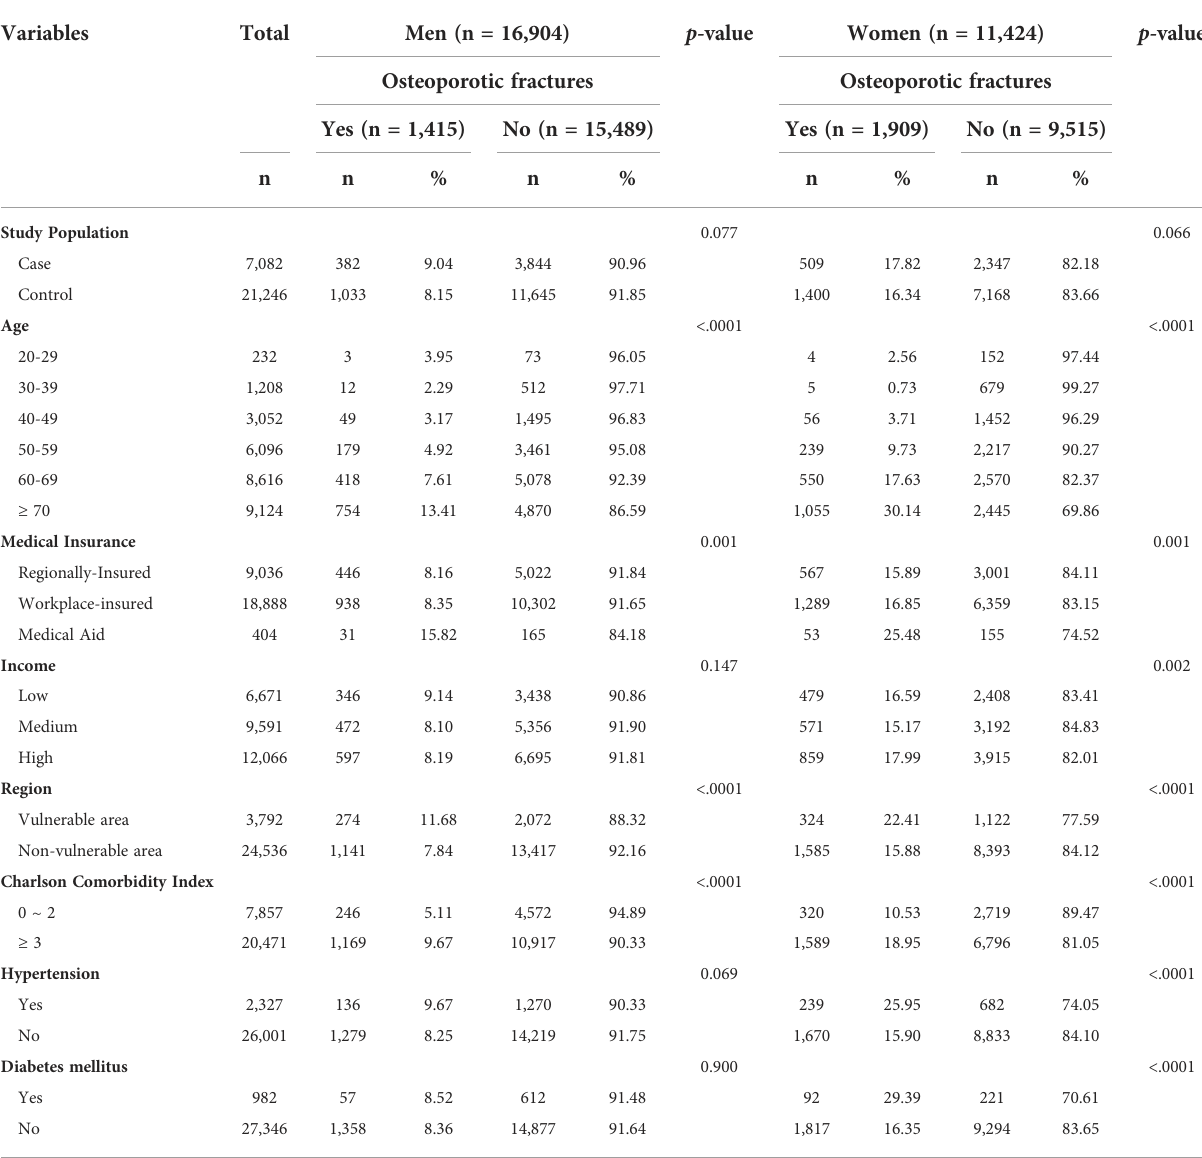
TABLE 1 General characteristics of the study population after 1:3 propensity score